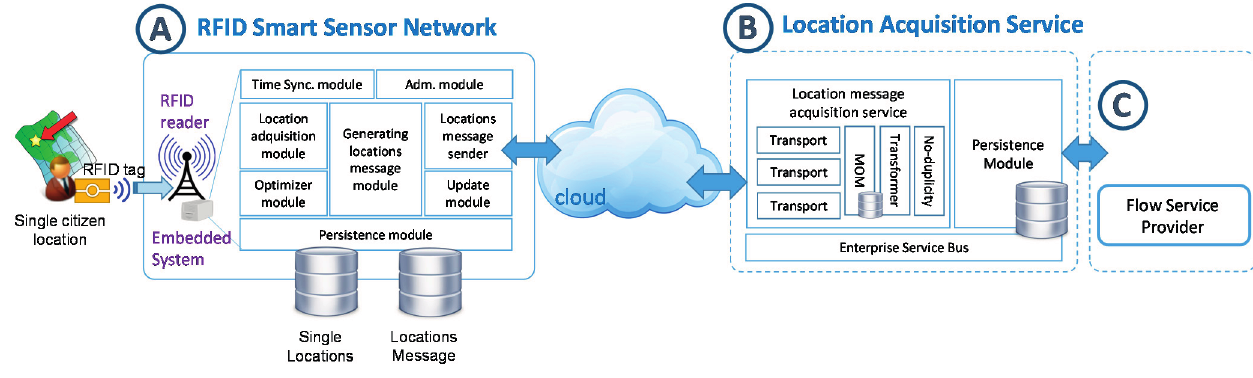
Figure 8. Location acquisition service